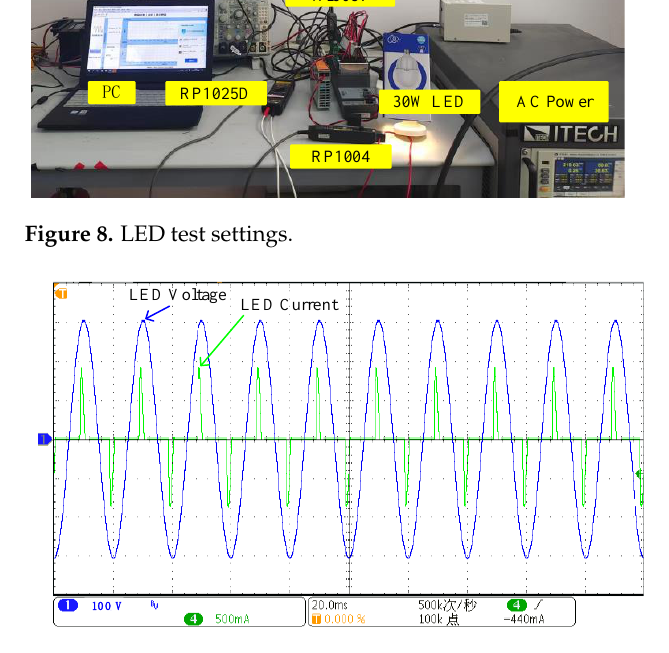
A simplified compressed sensing model with multiple measurement vectors is used